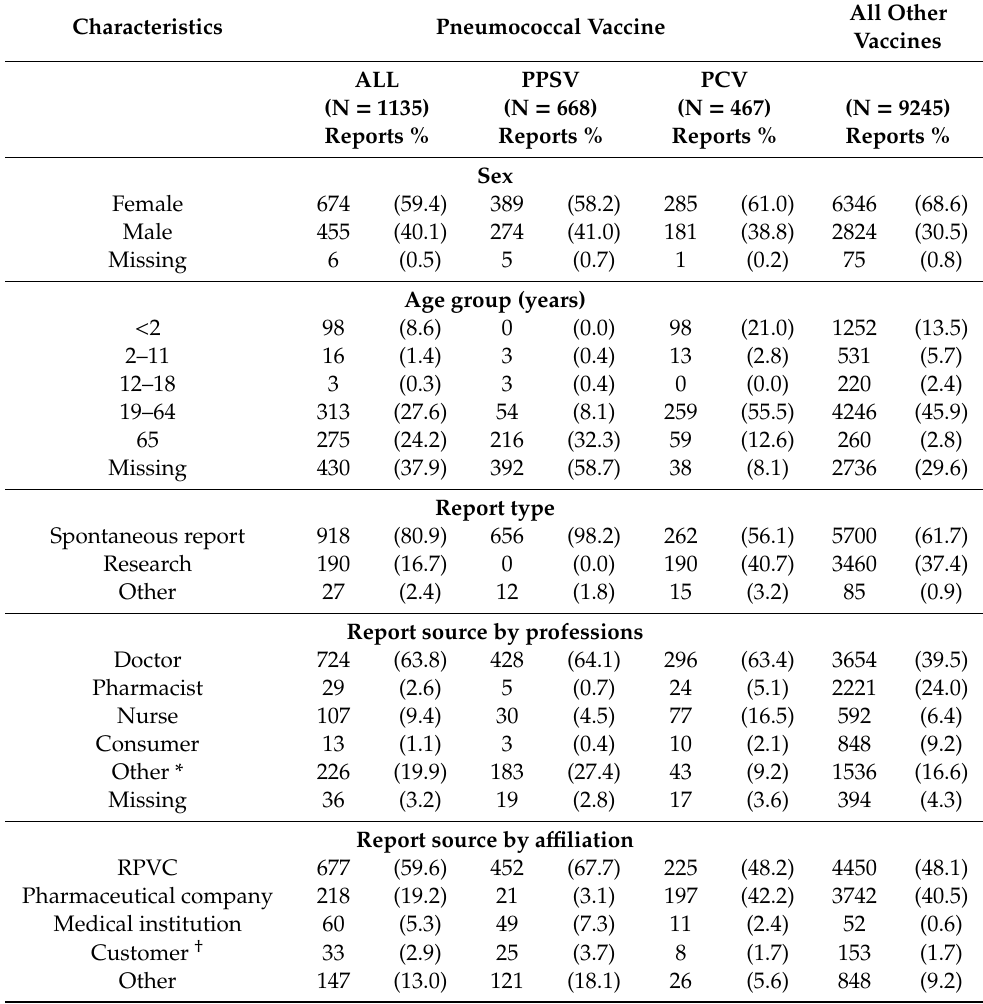
Table 1. Characteristics of adverse event reports related to pneumococcal vaccine and all other vaccines from 1988 to